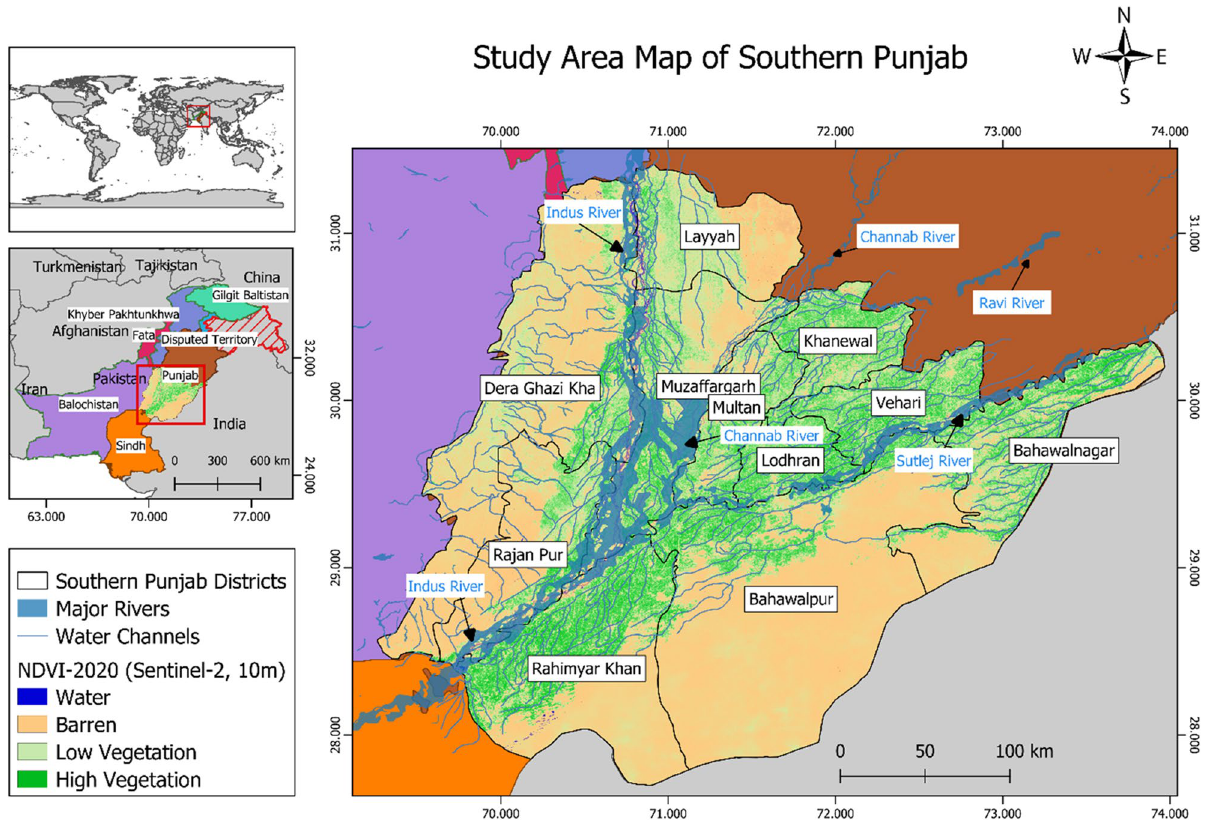
Figure 1. Map of the study area (Southern Punjab). The map is designed in ArcGIS Pro V2.9 software available at ESRI website (https:// www. esri. com/ en- us/ arcgis/ produ cts/ arcgis- pro/ overv iew). The boundary shapefile used to draw these maps are available at Humdata website (https:// data. humda ta. org/ datas et/ cod- ab-